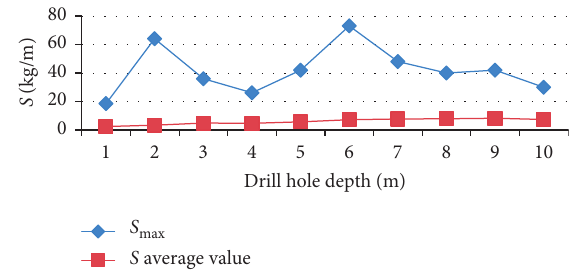
Figure 26: Distribution of 58 sets of prediction cycle drilling chip amount index S at different hole depths.